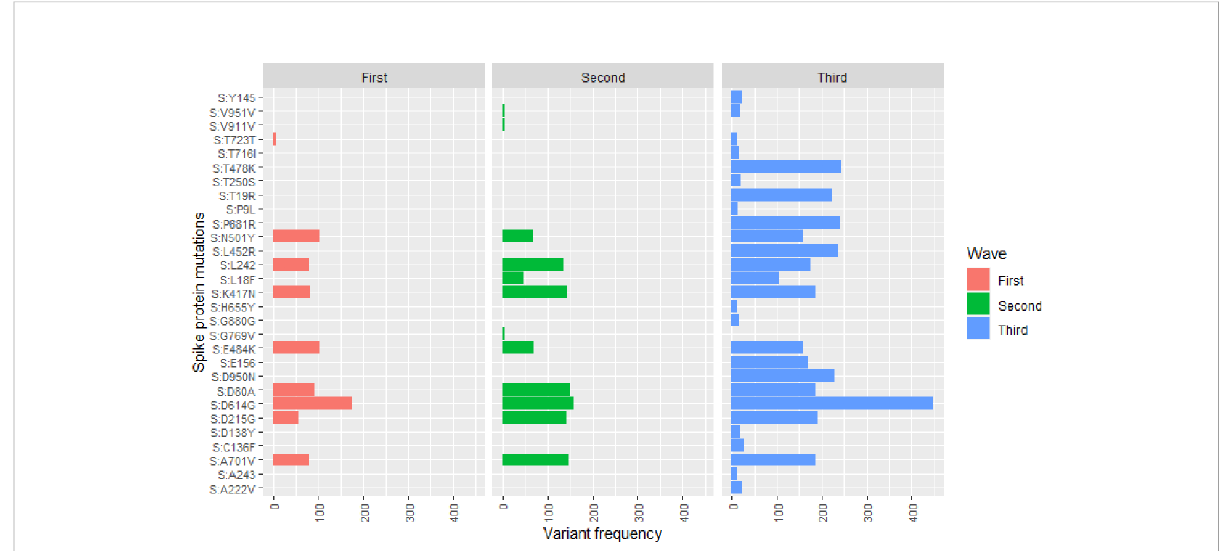
FIGURE 2 The frequency of spike protein mutations identi fi ed in SARS-CoV-2 variants during the epidemic waves. The x-axis indicates the frequency of the SARS-CoV-2 variants while the y-axis indicates the amino acid point mutation and the exact location identi fi ed within the SARS-CoV-2 protein structure. The fi rst, second and third waves are denoted by the red, green and blue colours, respectively.